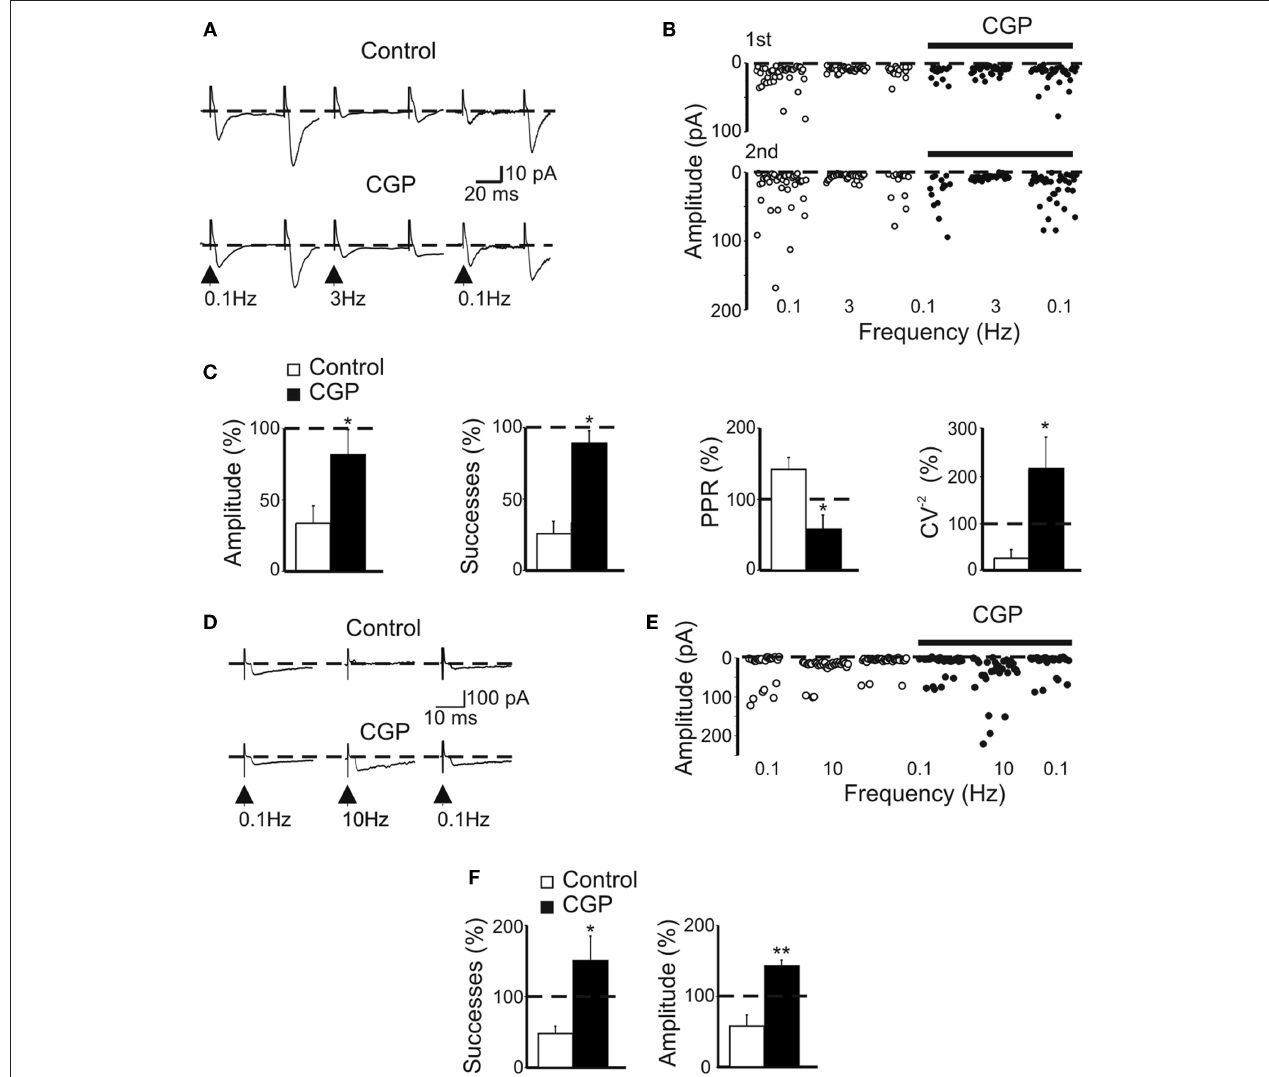
FIGURE 4 | CGP 55845 partially prevents frequency-dependent depression of MF-evoked GABAergic currents in CA3 principal cells. (A) Synaptic currents evoked in control (upper traces) and during application of CGP 55845 (lower traces) by stimulation of granule cells in the dentate gyrus at 0.1 Hz (left) at 3 Hz (middle) and again at 0.1 Hz (right). Each trace is the average of 20 individual responses. (B) The peak amplitude of synaptic currents [shown in (A) ] in control (open circles) and during CGP (bar, closed circles) are plotted as a function of different frequencies (shown below). (C) Summary data ( n = 12) representing changes in amplitude, success rate, PPR and CV − 2 at 3 Hz and normalized to those obtained at 0.1 Hz in control